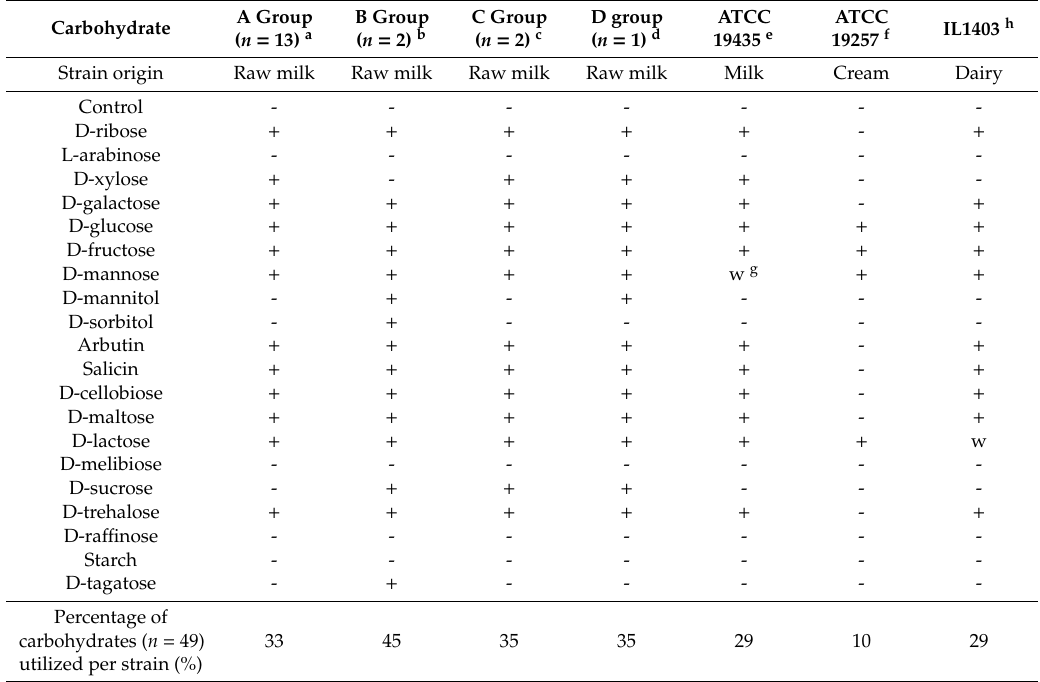
Table 6. Phenotypic characteristics of UMSC Lactococcus isolates. Phenotypic characteristics of two strain types, ATCC 19,435 and ATCC 19,257; data were extracted from Buron-Moles et al. and Yu et al. [14,53]. Phenotypic data of the type strain IL1403 was extracted from Siezen et al. [54]. A Group B Group Carbohydrate ( n = 13) a ( n = 2)